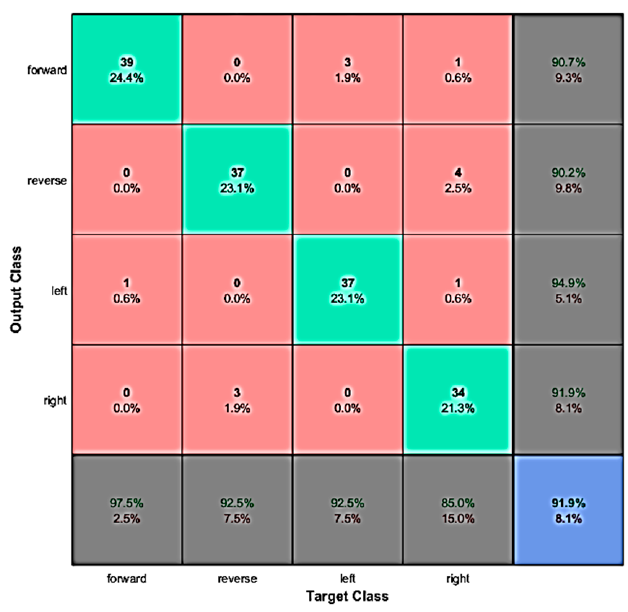
Figure 13. Confusion matrix for ages 32 to 40.